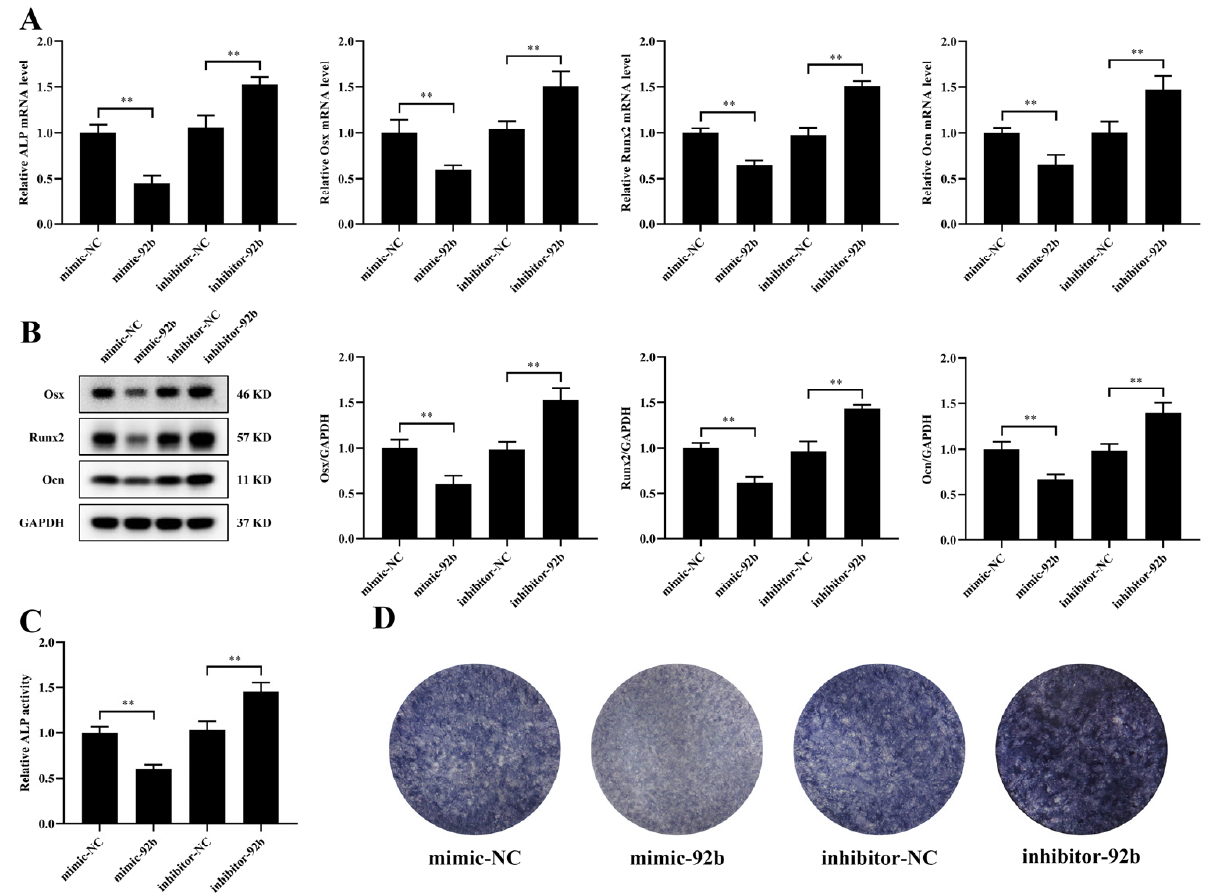
Figure 4. miR-92b-3p hinders the osteogenic differentiation of MC3T3-E1 cells. miR-92b-3p mimic, inhibitor, and miRNA negative controls were transfected into MC3T3-E1 cells. ( A ) mRNA expres- sion of ALP, Osx, Runx2, and Ocn in MC3T3-E1 cells analyzed by qRT ‒ PCR ( n = 3). ( B ) Protein levels of Osx, Runx2, and Ocn in MC3T3-E1 cells analyzed by Western blotting ( n = 3). ( C ) Relative ALP activity analysis in MC3T3-E1 cells ( n = 3). ( D ) Representative staining images for ALP in MC3T3-E1 cells ( n = 3). ** p < 0.01 vs. control.